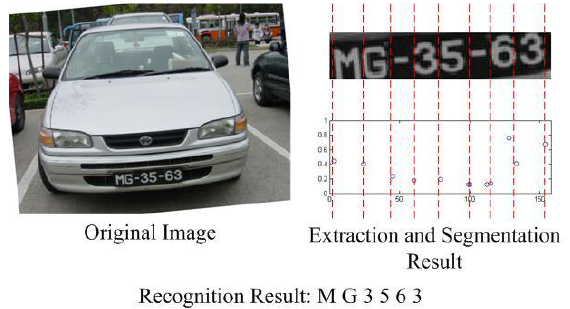
Figure 12: Experimental result with slanted license plate